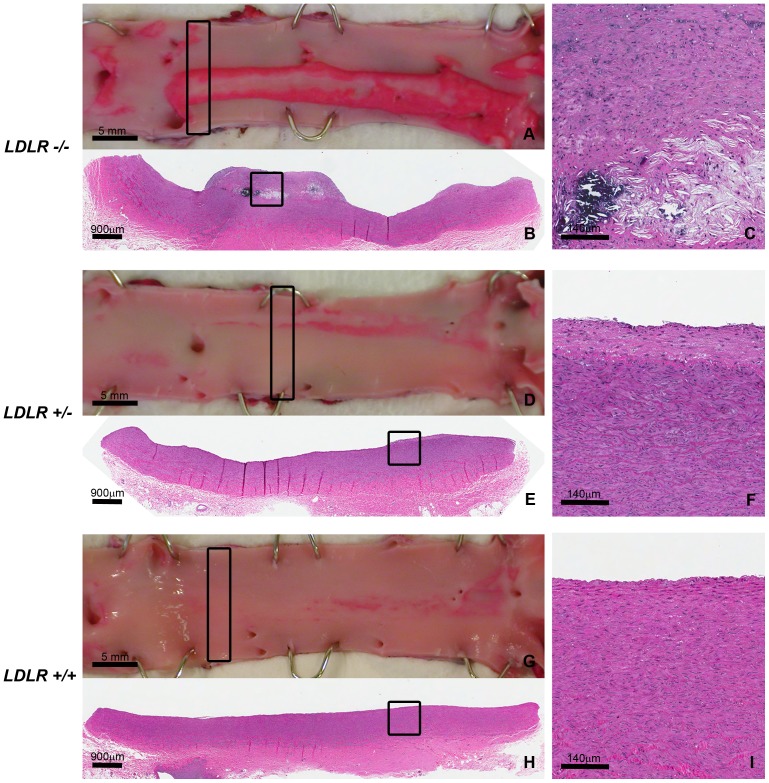
Abdominal aortic atherosclerosis in 11-month-old LDLR−/−, LDLR +/−, and LDLR +/+ pigs fed a high fat, high cholesterol diet.Measurements of percent surface area with raised lesion in the abdominal aorta were taken from en face photographs of the abdominal aorta and confirmed by Sudan IV staining (A,D,G). Aortic sections (rectangles) were stained with H&E (B, E, H) and higher magnifications of atherosclerotic lesion (squares) are seen in C, F, and I. Representative sections from each are shown: LDLR−/− (A,B,C), LDLR +/− (D,E,F), and LDLR +/+ (G,H,I). Atherosclerotic plaques from all the LDLR−/− pigs had cholesterol clefts and some lesions also exhibited calcification as shown in B and C.